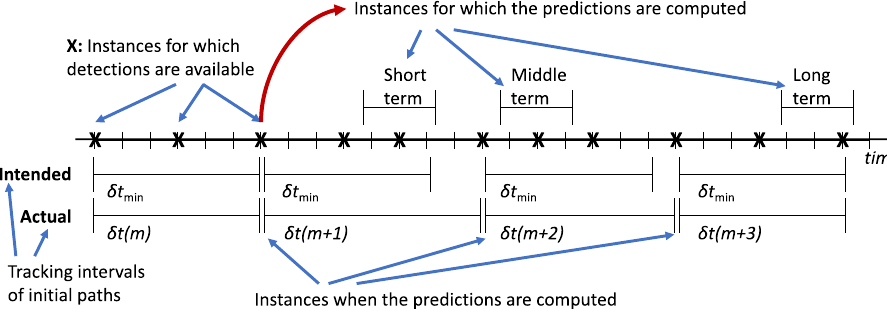
Figure 7: Timing diagram of the prediction test exemplifying the e ff ect of the random variation of detection